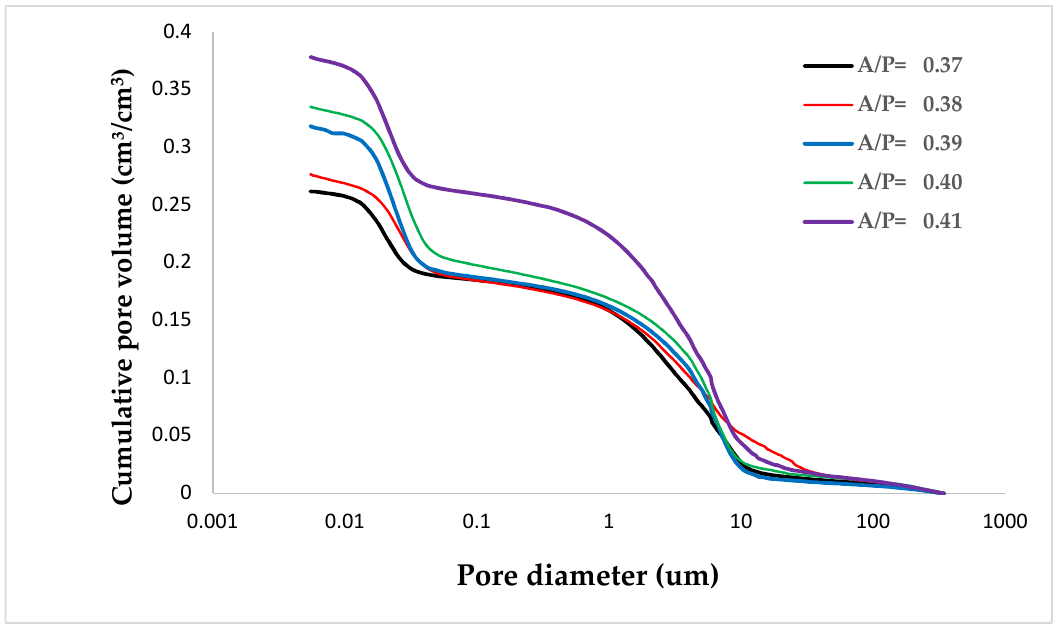
Figure 12. The cumulative pore volume curve for specimens cured for 28 days.